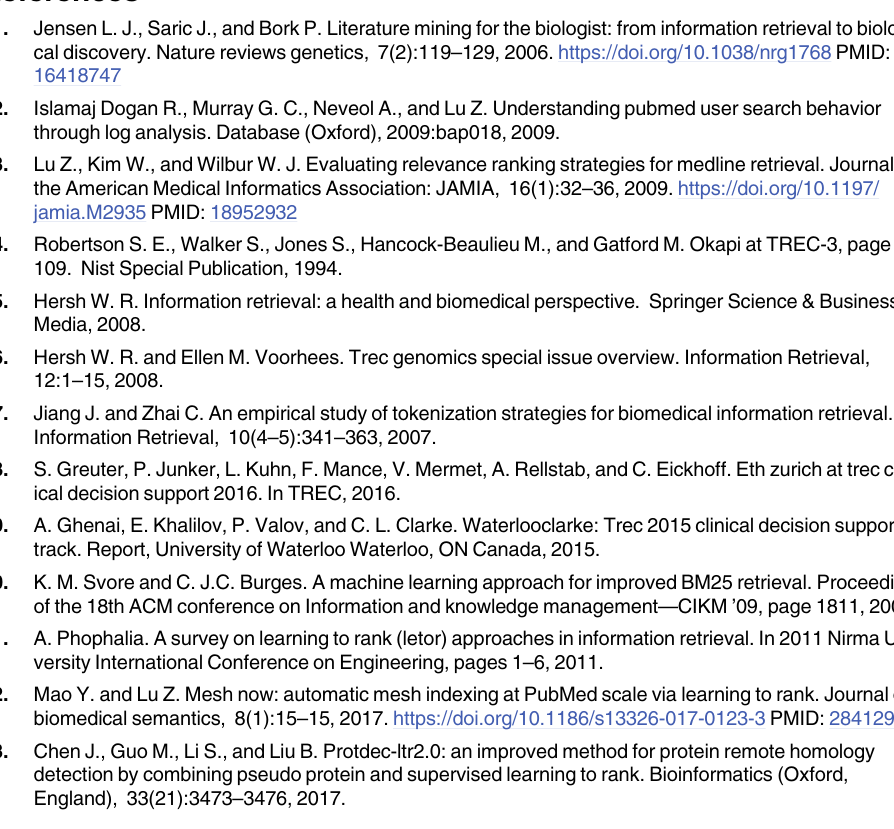
S1 Fig. Average click through rate at rank 20 for queries occurring less than 1,000 times. The observed overall average CTR@20 of near 0.4 appears to be strongly influenced by unique queries. The chart is cut at 1,000, but only a minimal number of queries occur more than a thousand times over a year. (TIF) S2 Fig. Offline evaluation of the new relevance algorithm against the silver standard extracted from the search logs. Precision-recall curves are plotted after the first step (green) and the second (blue) accordingly. A much higher precision is achieved after the second re- ranking step, especially for the top ranked results. (TIF) S3 Fig. Impact of feature ablation on overall ranking quality (measured by NDCG@20 scores).